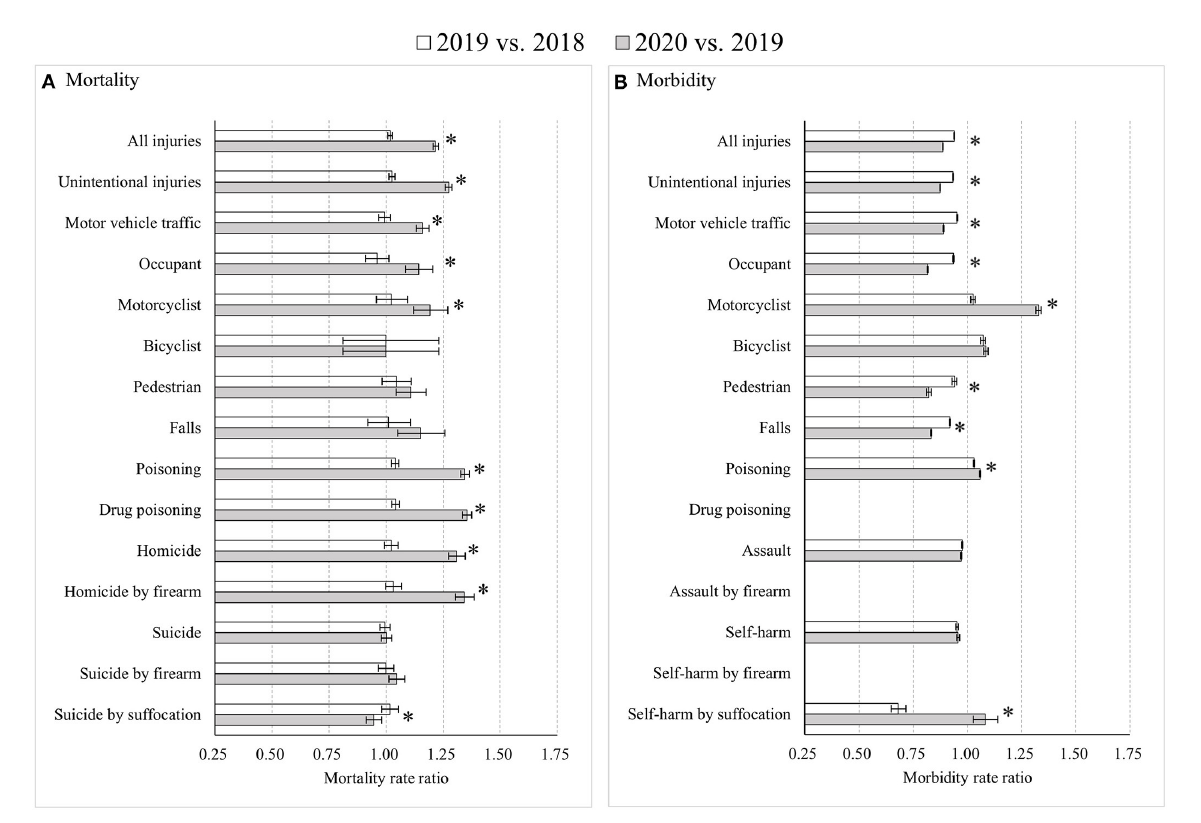
FIGURE3 Age-standardized injury mortality/morbidity rate ratios among Americans aged 25–44 years old, 2019 vs. 2018 and 2020 vs. 2019. (A) Mortality; (B) Morbidity. Results were omitted for categories having unstable injury morbidity rates (due to the computation based on cases < 20, the national estimates < 1,200, the coefficient of variation > 30%, or the tool not involving details regarding mechanism of relevant injury). “*” indicates that the differences of MtRRs or MbRRs between 2020 vs. 2019 and 2019 vs. 2018 were statistically